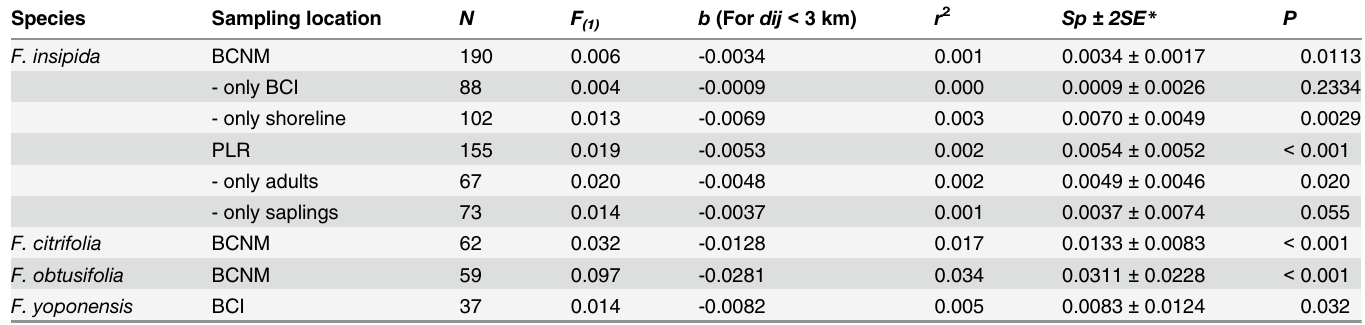
Table 2. Estimates of SGS based on the Sp statistics. With b : slope of the regression with the correlation coefficient r 2 and F (1) = kinship coefficient for the first distance class (d < 200 – 300 m).